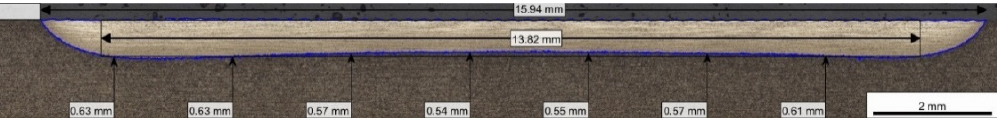
Figure 13. Optical microscope of the hardened track of the specimen after polishing and etching. The probe was hardened with an optimized intensity profile at a feed of 1000 mm/min.